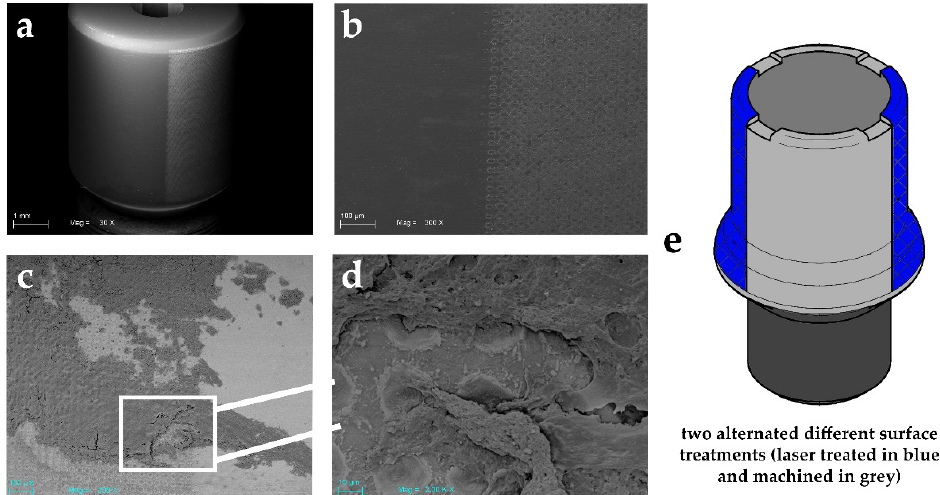
Figure 1. SEM images showing an experimental healing abutment used in this study: ( a ) showing the two di ff erent alternated surface treatments (laser treated on right and machined on left). Scale bar: 1 mm; ( b ) high magnification of these two surfaces topography. Scale bar: 100 µ m; ( c ) soft tissue adhesion on both the studied surfaces. Please note the high quantity on the laser-treated surface compared to the machined one Scale bar: 100 µ m; ( d ) higher magnification of the selected zone (Scale bar: 10 µ m) and its interaction with soft tissue after biopsy; ( e ) technical design of experimental healing abutment.